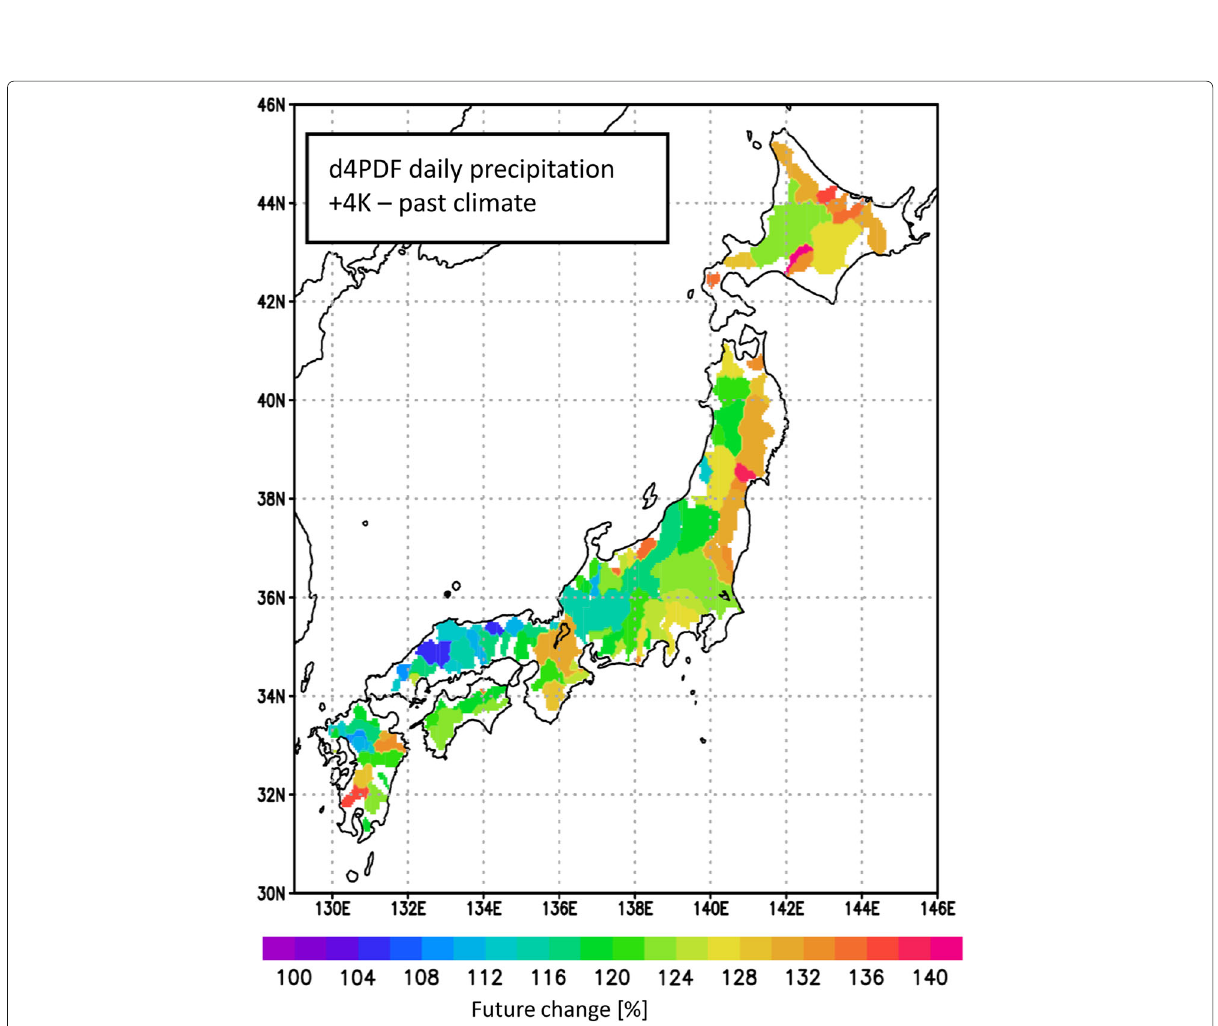
Fig. 8 Future changes in the maximum precipitation averaged over the first-class river basins (future minus past, unit: %), after Hoshino and Yamada